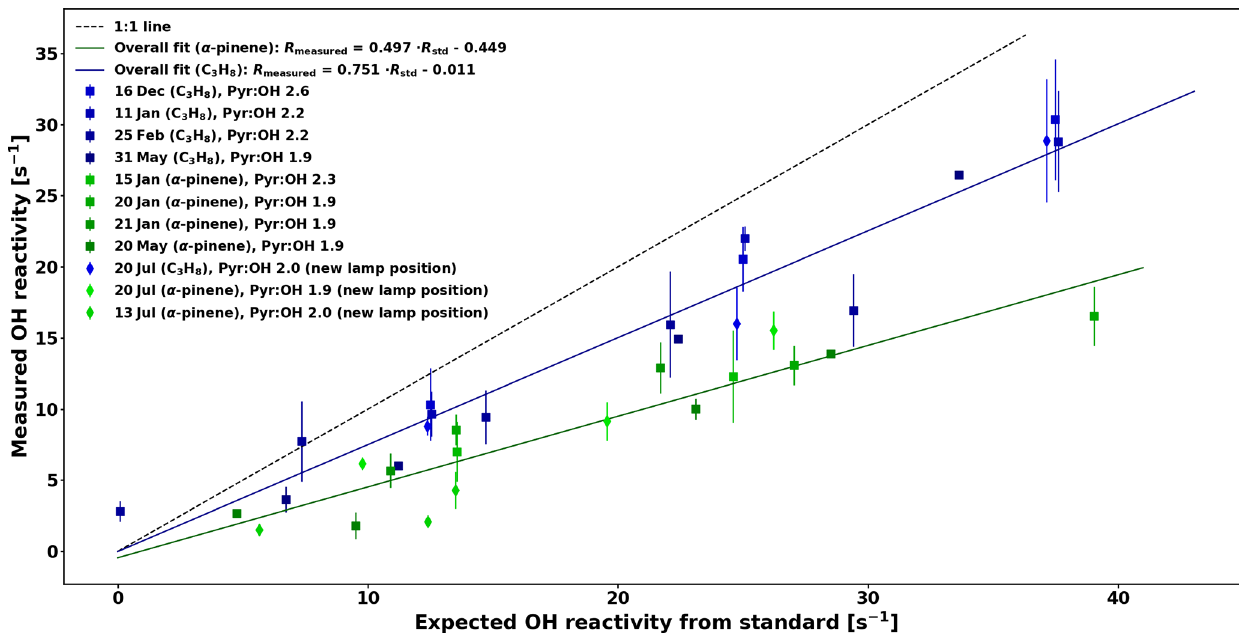
Figure 5. Comparison between measured OH reactivity for C 3 H 8 and α -pinene standards with the expected OH